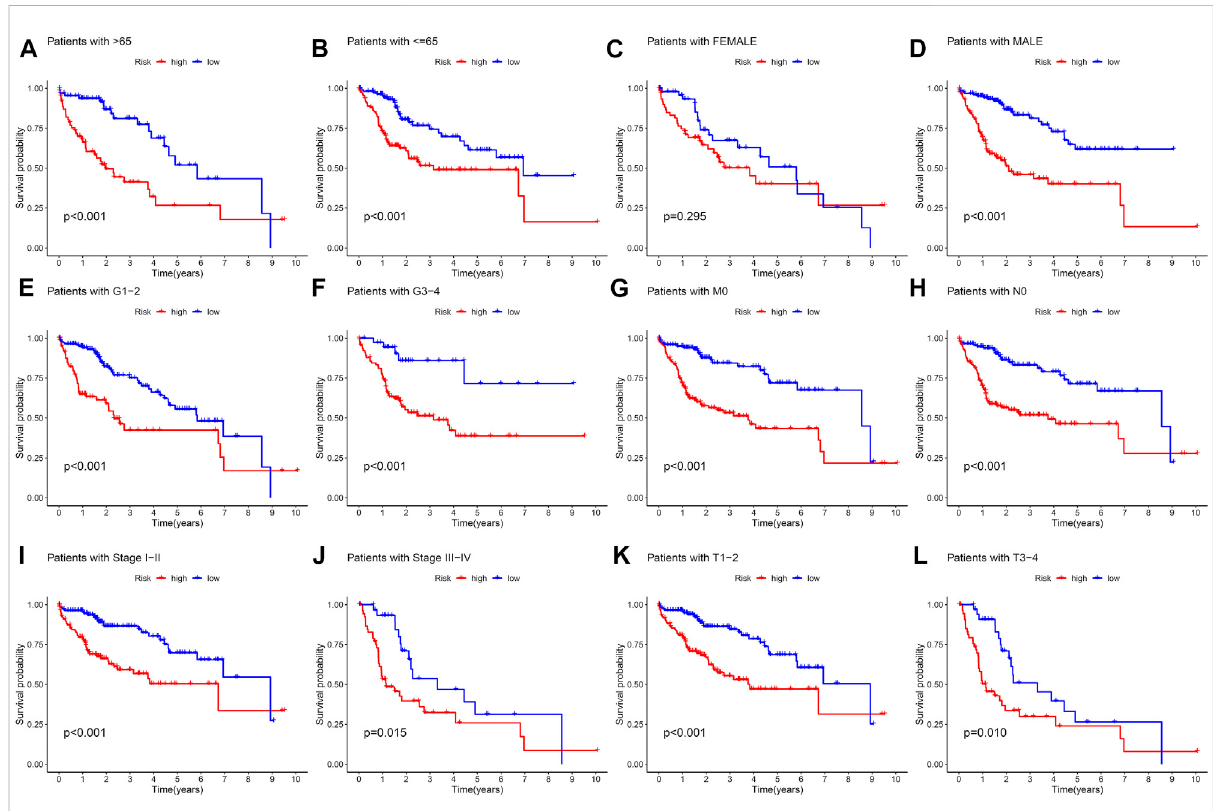
FIGURE 3 Kaplan – Meier curves of OS differences strati fi ed by sex, age, grade, pathological stage, N stage, M stage, and T stage between high-risk and low-risk groups. (A,B) Age > 65 and Age < =65. (C,D) Female and male. (E,F) Grade stage 1 – 2 and Grade stage 3 – 4. (G,H) M0 stage and N0 stage. (I,J) pathological stage I – II and pathological stage III – IV. (K,L) T stage 1 – 2 and T stage 3 –